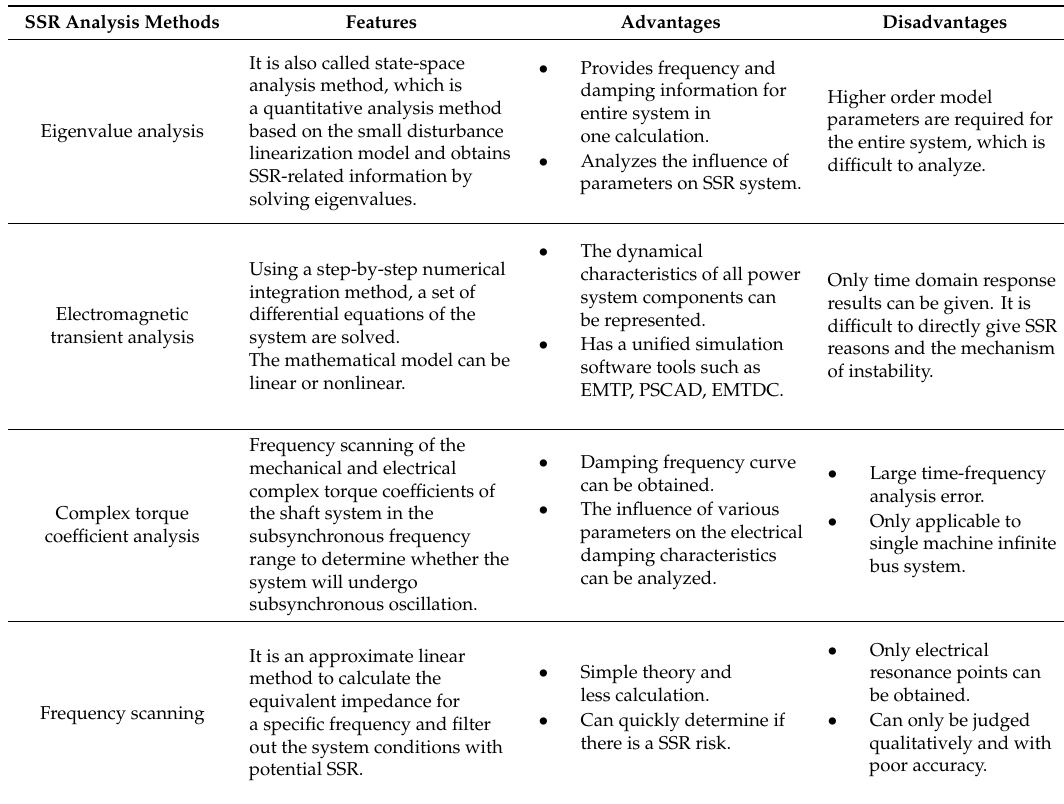
Table 1. Comparison of subsynchronous resonance (SSR) analysis